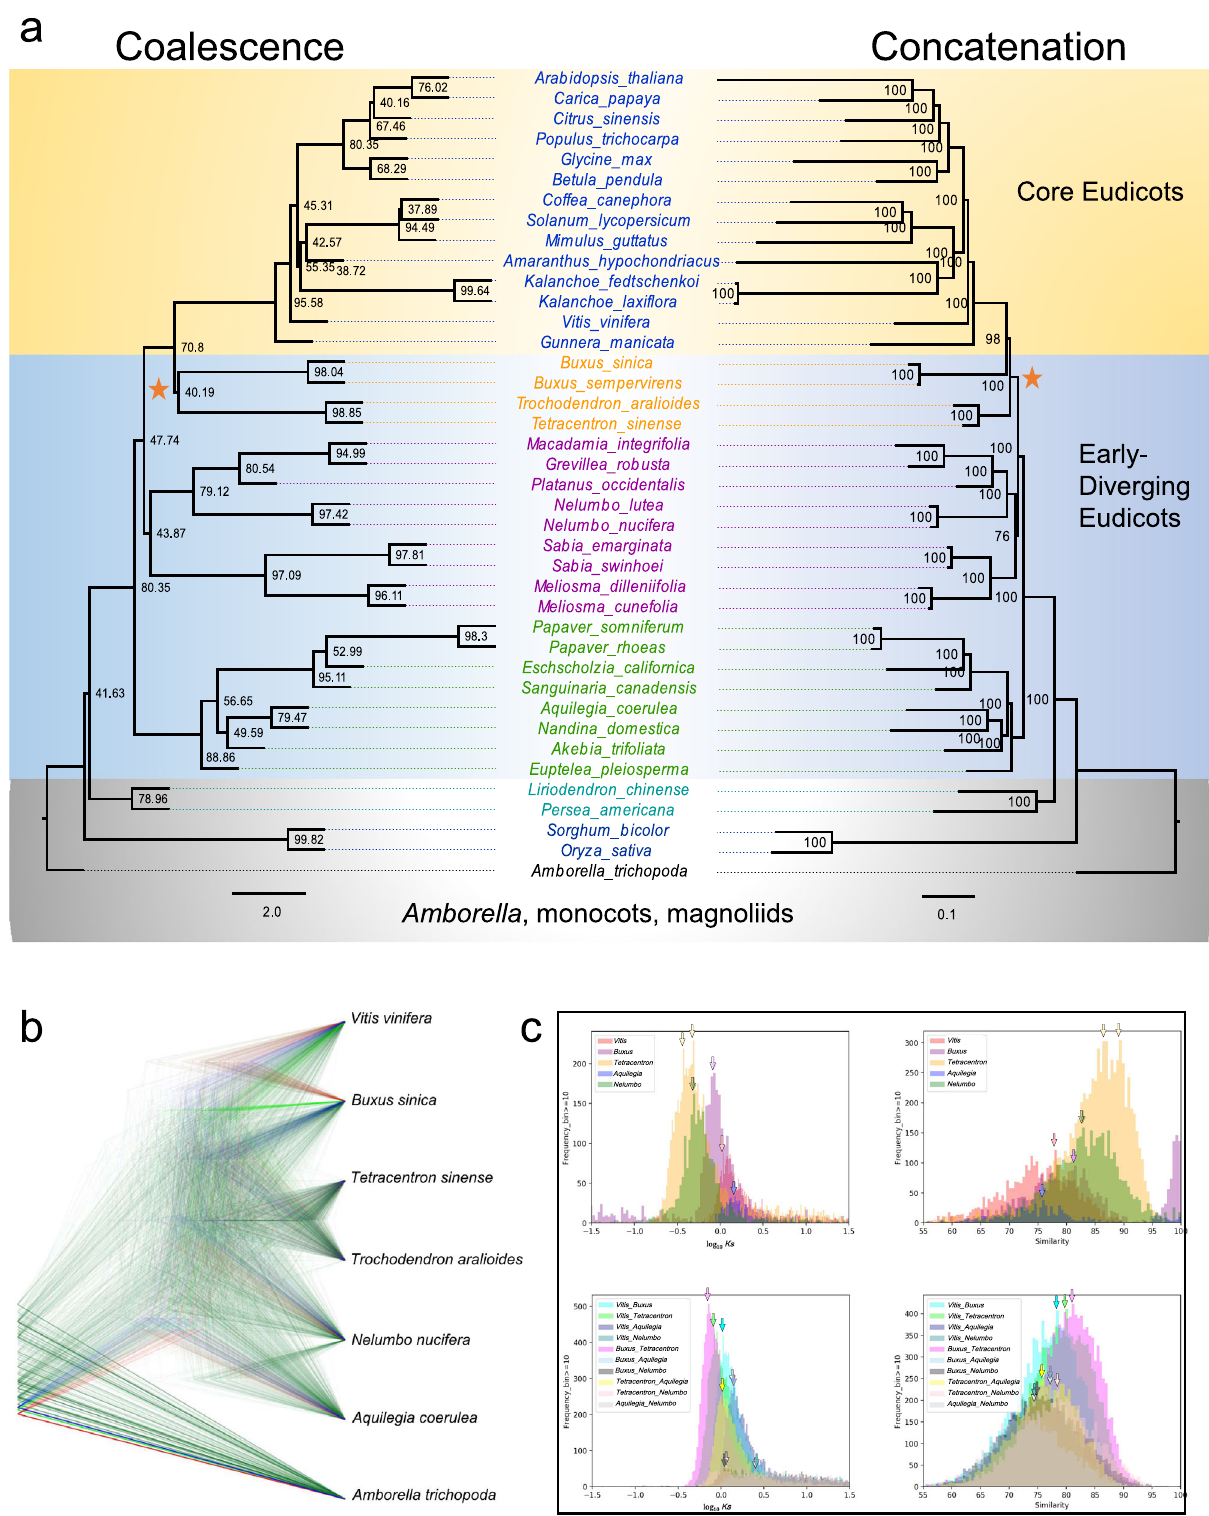
Fig. 2 Phylogenetic relations of Buxus and Tetracentron . a Phylograms depicting the coalescent solution of individual Maximum Likelihood (ML) gene trees (left) and partitioned ML analysis of a supermatrix of nucleotide sequence alignments (right). Node labels indicate quartet (coalescence) and bootstrap (supermatrix) support values, and orange stars highlight the positions of Buxales and Trochodendrales in the two trees. b Cloudogram of 763 SCN gene trees illustrating discordance surrounding the deep branches of eudicot phylogeny. The most frequent trees are blue, the next most frequent red, the third most frequent green, and the rest are dark green. c Ks (left) and Similarity (right) distributions showing peaks (arrows) that stem from WGD (top) and speciation events (bottom), respectively. Source data underlying Fig. 2b, c are provided as a Source data fi